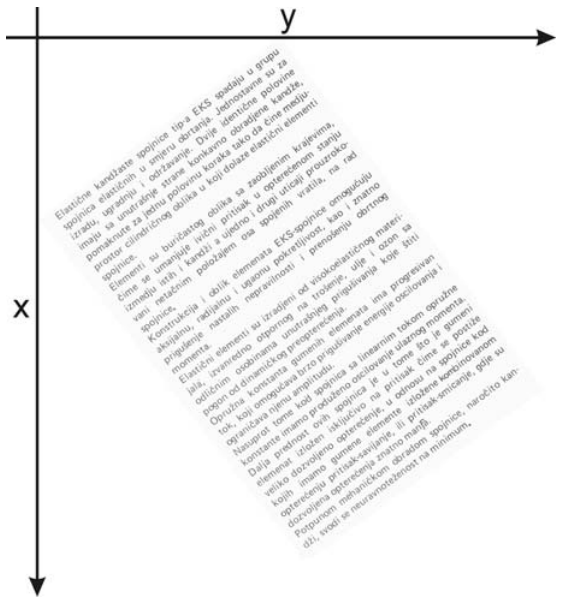
Figure 2. Document text